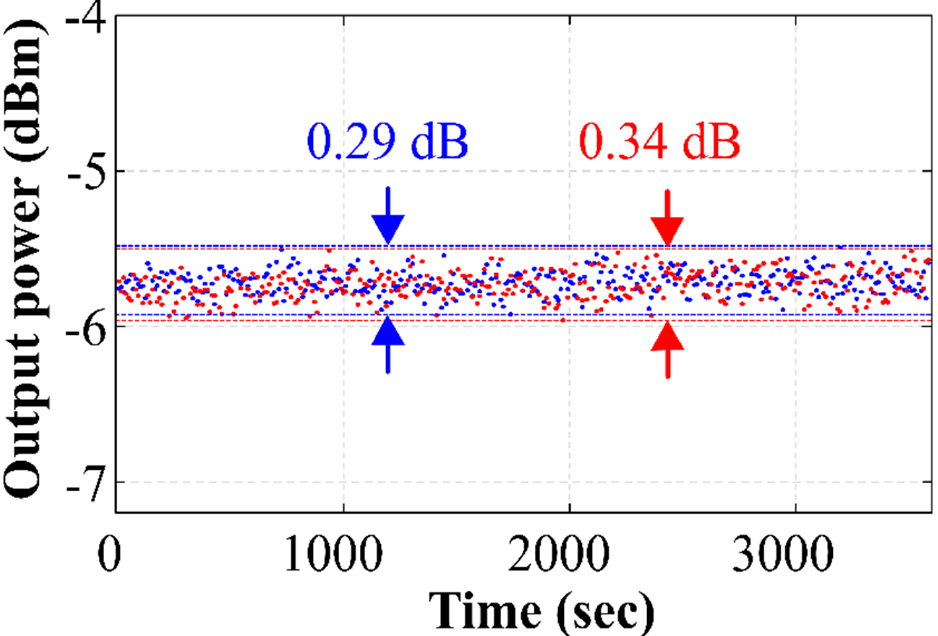
Figure 8. Output power stability of the 1527.70 nm (blue) and 1530.81 nm (red) emission lines when pumped at 400 mW, measured over 1 h with a CL of 95%.